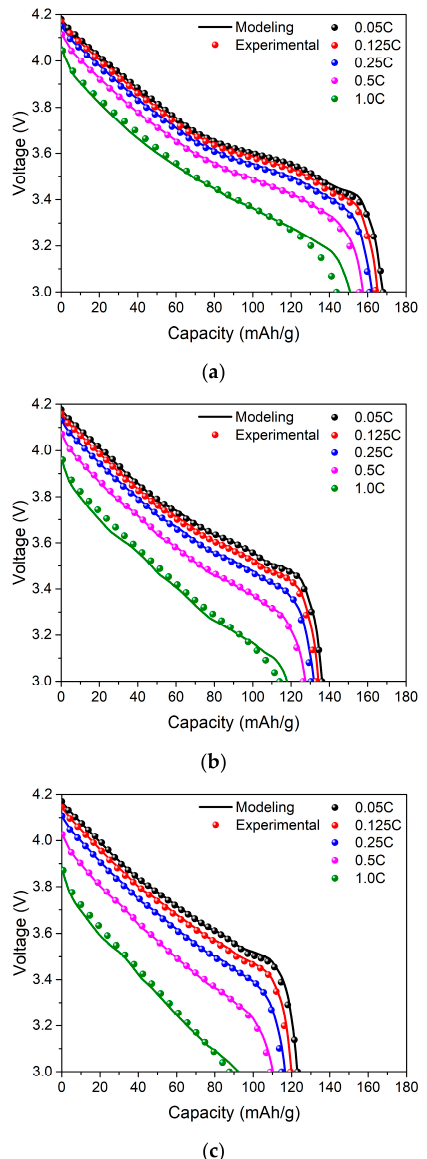
Figure 5. Comparison between experimental and modeling discharge curves with discharge rates ranging from 0.05 C to 1 C for the LIB cells with three di ff erent levels of the loss of cyclable lithium: ( a ) 0%; ( b ) 10%; and ( c )